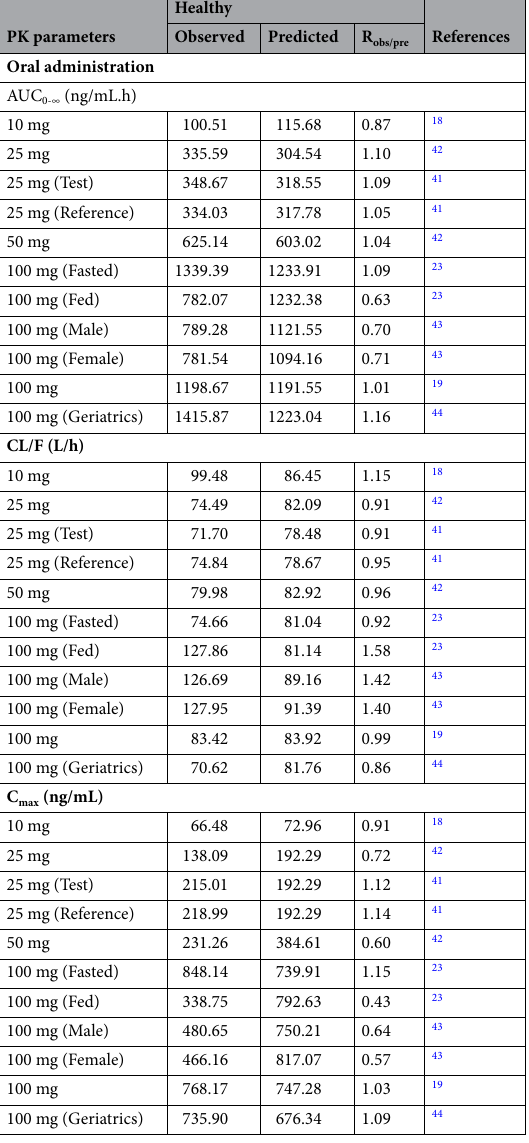
Table 6. The R obs/pre of PK parameters in healthy adults after oral administration of